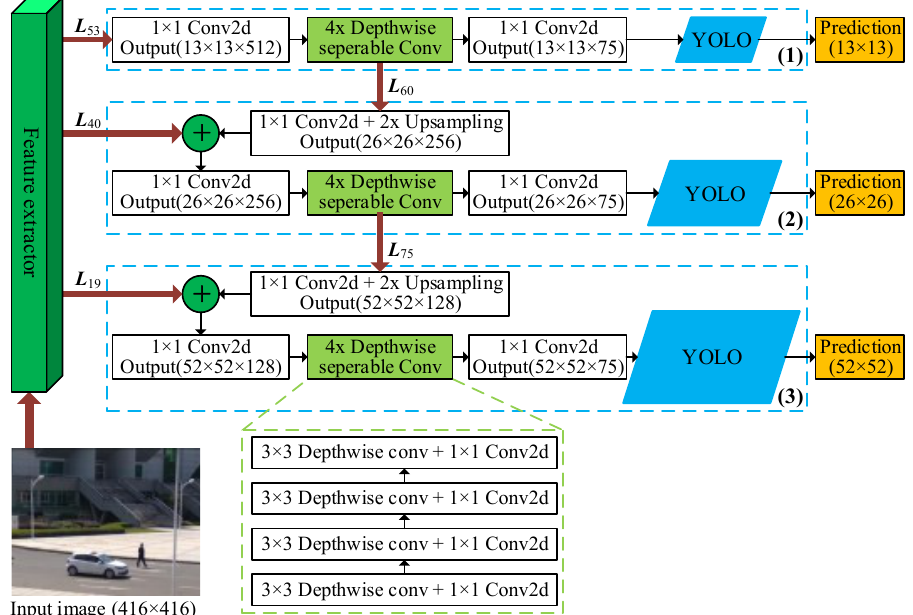
Figure 3. Illustration of the proposed depthwise feature pyramid network. + (cid:13) denotes a route layer. The difference from YOLOv2 [23] and YOLOv3 [24], the MYOLO3 is mainly built on bottleneck residual blocks and depthwise separable convolutions, instead of standard residual blocks and conventional convolutions. Moreover, a bottleneck residual block-based MobileNetv2 is used to extract feature maps, and then a newly designed depthwise feature pyramid network is used to predict the locations and scores of detection objects. There are three reasons for this: (1) Compared with standard residual blocks, bottleneck residual blocks enable created networks to obtain improved accuracy by outputting linear activations, and have less computation cost. (2) Depthwise separable convolutions have fewer parameters than standard convolutions, and thus are less prone to over-fitting. (3) With fewer parameters, depthwise separable convolutions also require fewer computations and thus are